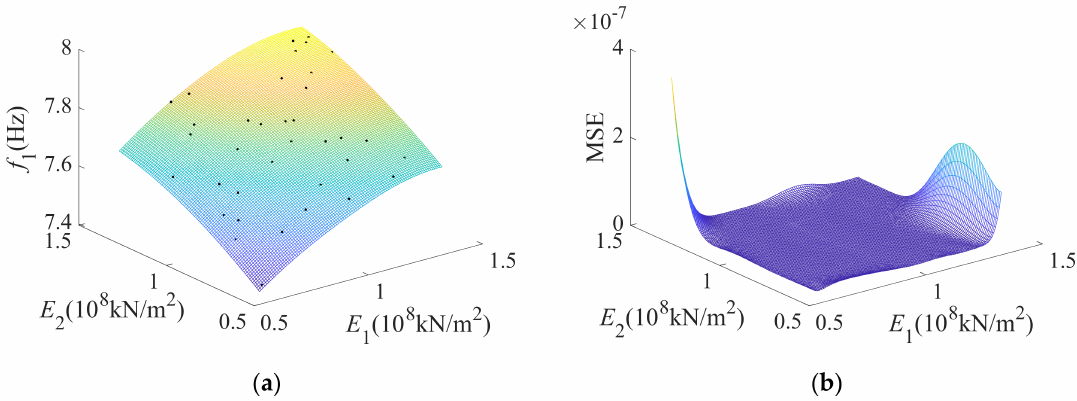
Figure 6. The first-order frequency kriging model and the corresponding MSE: ( a ) kriging model; and ( b )